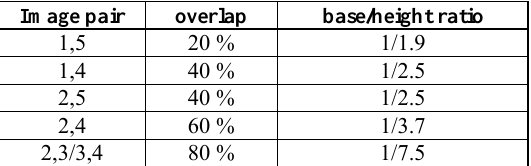
Table 4. Image pair combinations and the base/height ratios of the digital large format camera